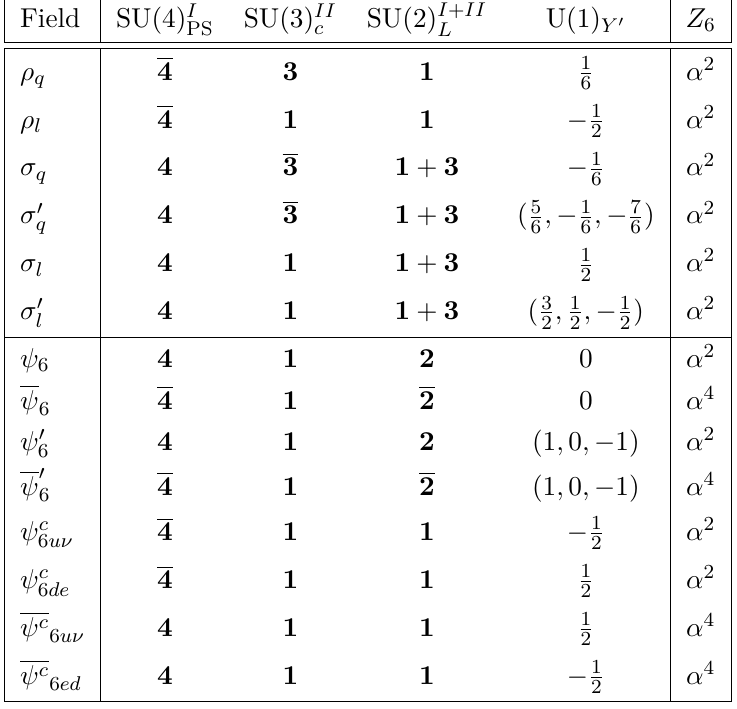
Table 6 . Under the subgroup G 4321 , the extra fields of tables 4, 5 decompose as